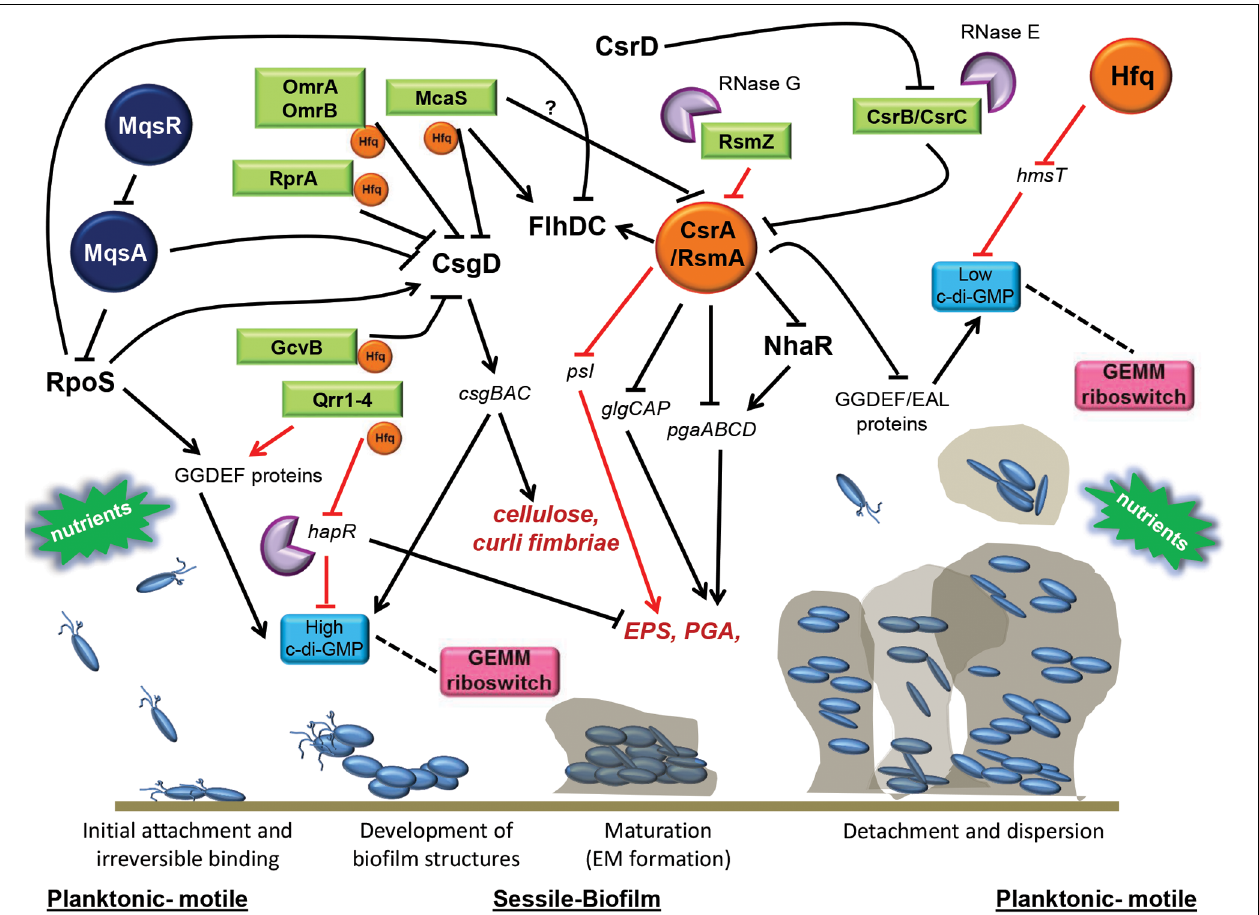
FIGURE 1 | Post-transcriptional regulatory networks directing biofilm formation. Numerous post-transcriptional regulatory factors, mainly affecting biofilm maturation at the level of synthesis or exopolysaccharides has been described currently and are represented here. The RNA-binding protein , CsrA, represses biofilm formation by directly and indirectly affecting stability of mRNA transcripts encoding important polysaccharides constituting the extracellular biofilm matrix. CsrA acts alternately by repressing GGDEF/EAL encoding proteins which determine c-di-GMP levels , or by favoring motility, rather than biofilm formation, by stabilizing transcripts encoding the master regulator of flagella, FlhDC. Several ncRNAs (OmrA/B, RprA, GcvB, McaS) regulate biofilm by repressing csgD , encoding the CsgD master regulator involved in the production of curli fimbria, cellulose, and c-di-GMP. Other ncRNAs (CsrB/CsrC, McaS) favor biofilm formation by blocking CsrA activity (e.g., in E. coli and Salmonella ) or by positively affecting production of c-di-GMP (Qrr1-4) and expression of exopolysaccharides (e.g., V. cholerae ). To exert their function, many of these sRNAs need to be bound to the RNA-binding chaperone Hfq, which has been reported to also repress biofilm by affecting the expression of the GGDEF protein, HmsT ( Y. pestis ), required to synthesize c-di-GMP. Changes in the levels of c-di-GMP are sensed by the